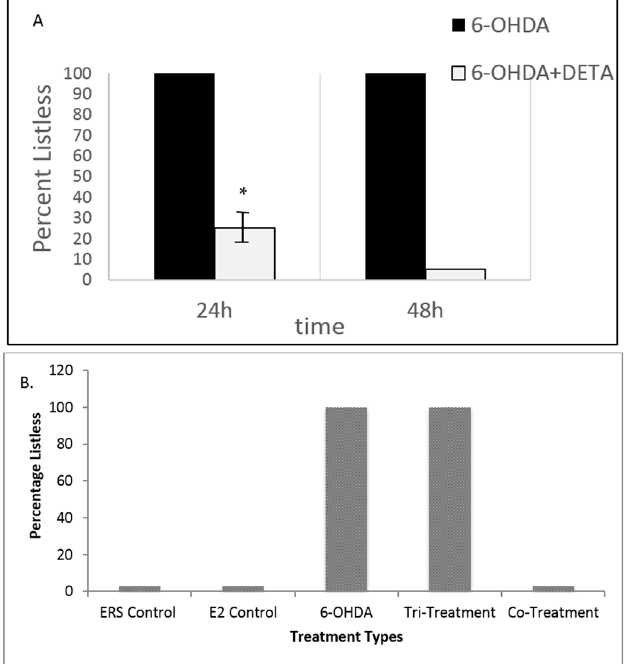
Figure 3. Rescue of 6 dpf fish from the 6OHDA-induced listless/PD-like phenotype under various treatment conditions. ( A ) DETA-NO co-treatment rescues fish from 6OHDA-induced listless symptoms. Specifically, at 24 and 48 h after treatment 100% of the 6OHDA treated population of fish exhibit listless/PD-like symptoms. In contrast, the co-treatment (6OHDA + DETA-NO) significantly (* p < 0.05) rescues fish from this phenotype at both 24 and 48 h after treatment. Specifically, by 24 h of co-treatment only approximately 25% of fish demonstrated the listless phenotype, while at 48 h all fish had recovered; ( B ) the effects of estrogen (E2) on 6OHDA treated fish. At 24 h after treatment, 100% of the 6OHDA treated population of fish exhibit listless/PD-like symptoms. In contrast, the co-treatment (6OHDA + E2) rescues 100% of fish from this phenotype at 24 h after treatment. However, the tri-treatment (6OHDA + E2 + nNOSI) eliminates all effects of the E2 co-treatment rescue phenomenon. In contrast, ERS and E2 treatments alone show no listless/PD-like phenotypes. Bars represent ± SD.